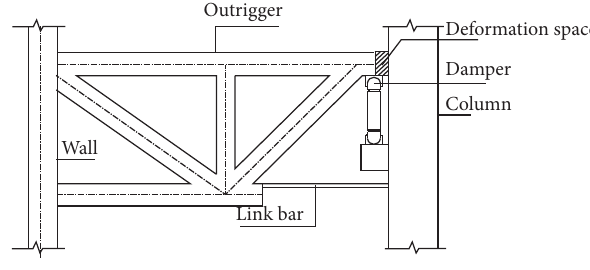
Figure 7: Damped outrigger layout.